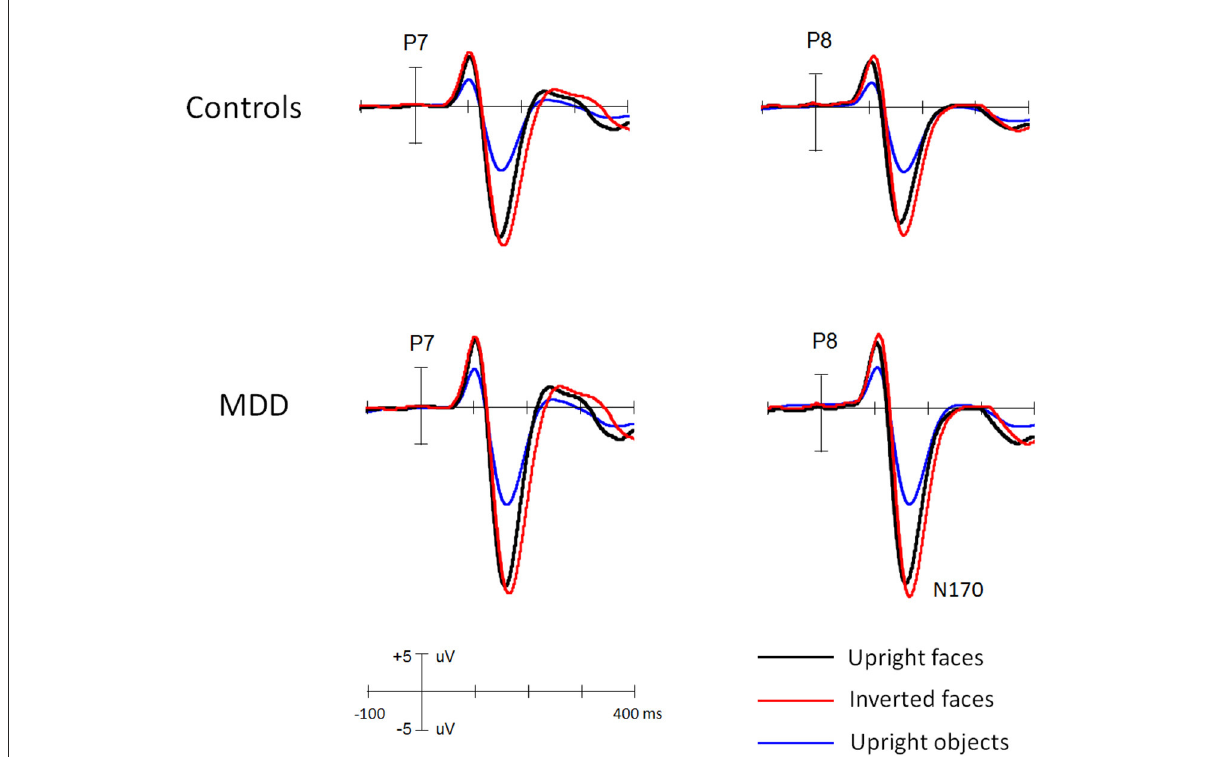
FIGURE2 The grand ERP waveforms elicited by faces and objects in middle-aged MDD patients and controls, respectively.